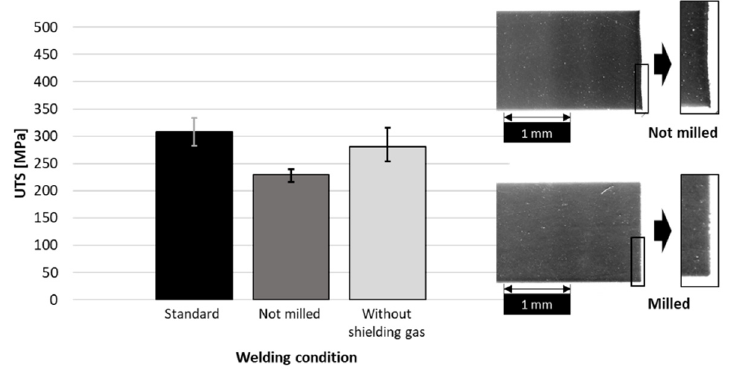
Figure 5. Influence of specimen preparation and shielding gas on the UTS of the welding seam. The second parameter investigated in the experiments was the welding speed.